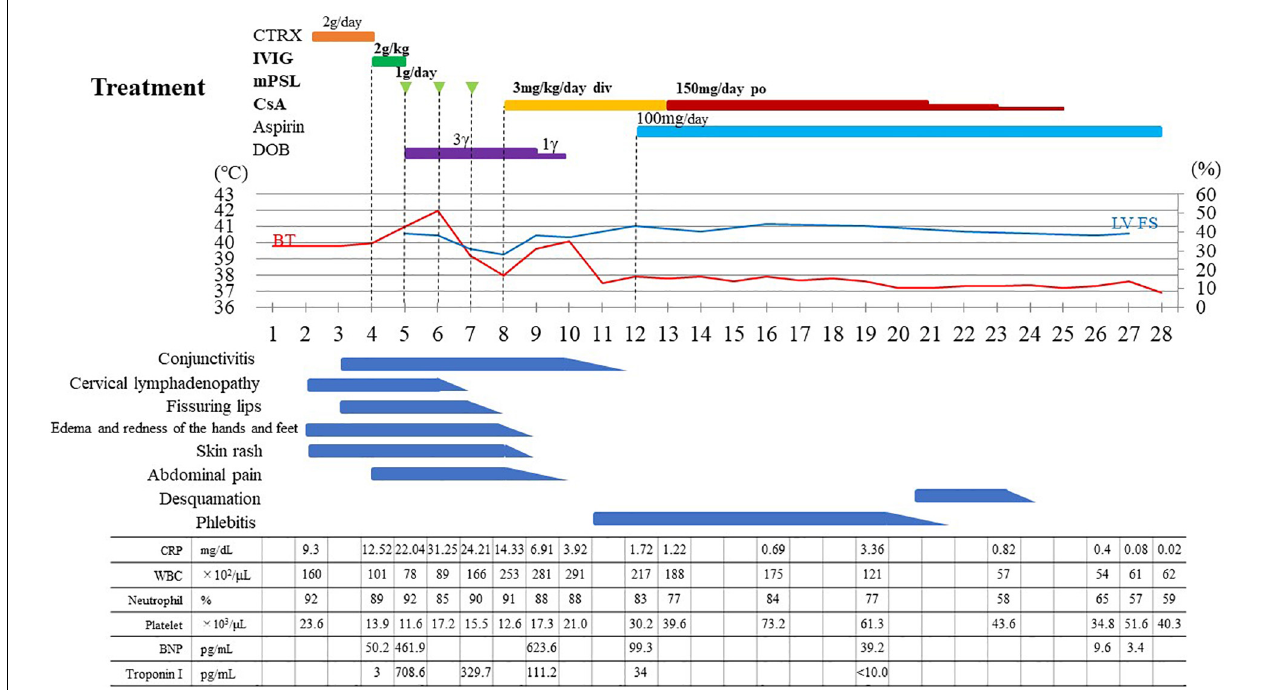
FIGURE 1 | Treatment and clinical course of the patient. CTRX, ceftriaxone; IVIG, intravenous immunoglobulin infusion; mPSL, methylprednisolone pulse; CsA, ciclosporin A; DOB, dobutamine; LV FS, left ventricular fractional shortening; BT, body temperature; CRP, C-reactive protein (reference range < 0.14); WBC, white blood cell (reference range 4,000–10,700); BNP, B-type natriuretic peptide (reference range < 18.4); Toroponin I (reference range < 26.2); CTR, cardiothoracic